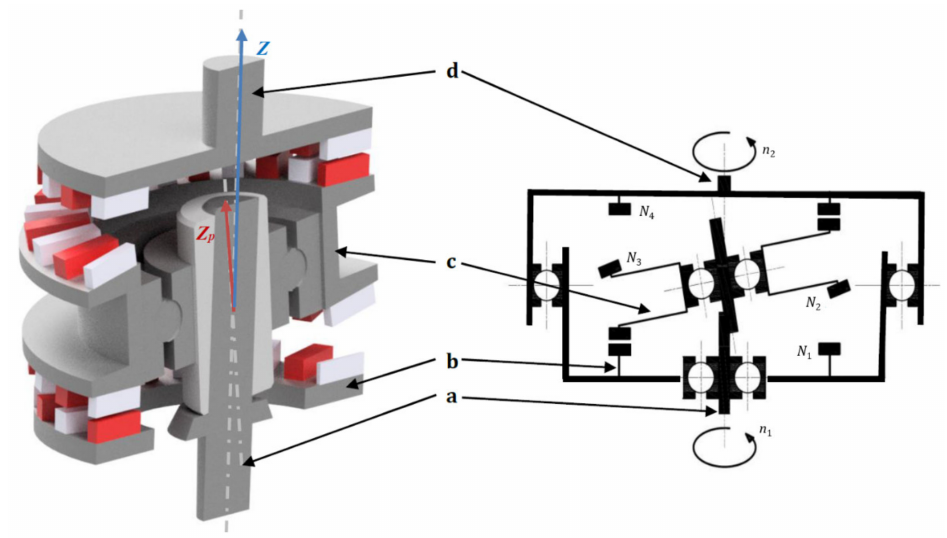
Figure 3. Concept and kinematic scheme of the magnetic two-stage precession gear: a, input shaft; b, immovable ring; c, intermediate ring; and d, output ring with output